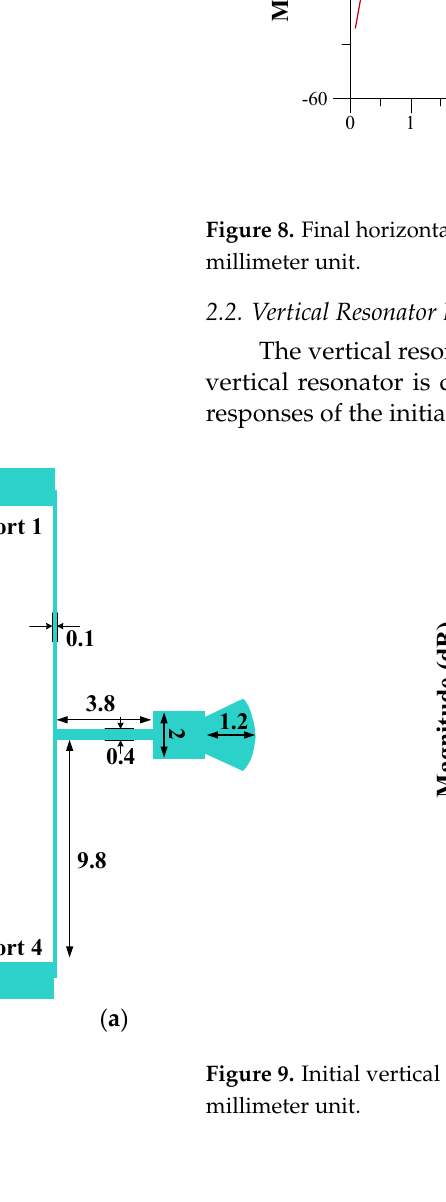
( b ) Figure 10. Improved initial vertical resonator: ( a ) layout and ( b ) frequency response. All dimensions are in the millimeter unit. The final vertical resonator can be obtained by adding another stepped impedance resonator to the improved initial vertical resonator. The layout and frequency response of the final vertical resonator is shown in Figure 11.